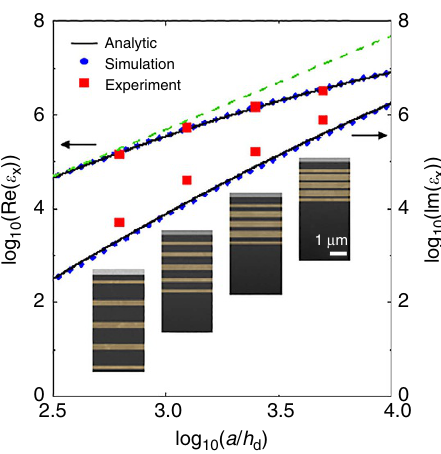
Figure 3 | Effective dielectric constants as a function of the aspect ratio ( a / h d ). The homogenized dielectric constants are plotted on a logarithmic scale at 10 GHz. The green dashed line is a visual guide for quadratic dependence. The dielectric thickness of four fabricated samples are h d ¼ 1,200, 600, 300, and 150nm, respectively, and other parameters are same as Fig. 2. Even for the sample with h d ¼ 150nm, Im[ e x ] is an order of magnitude less than Re[ e x ], with a refractive index larger than 1,800. The scanning electron microscope images in all four insets have the same scale and are recoloured to show the metal region